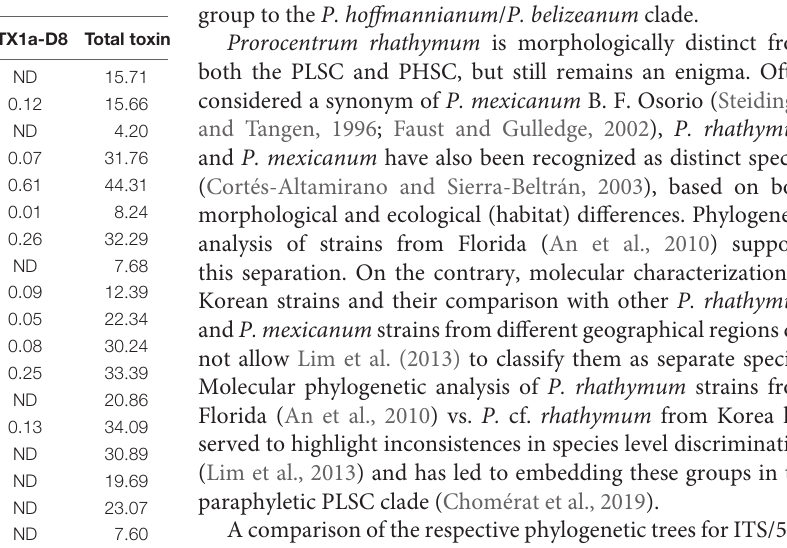
TABLE 2 | Cell content of DSP toxins (OA and DTX plus analogs) from cultured benthic Prorocentrum isolates assigned to the P. lima complex (PLSC).